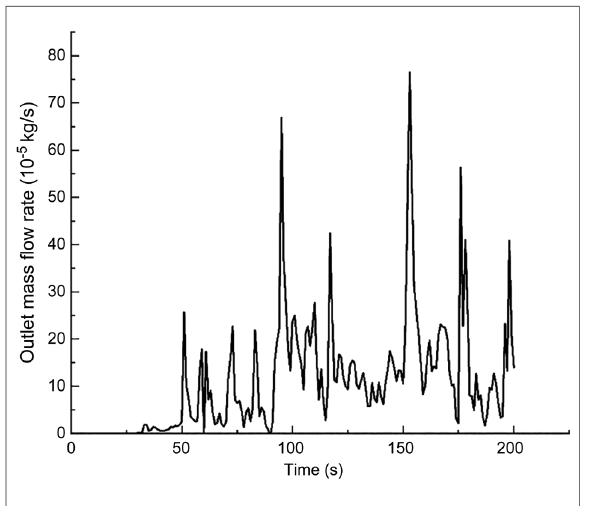
FIGURE 11 The outlet mass fl ow rate monitoring graph of the curved model of the curved incision.